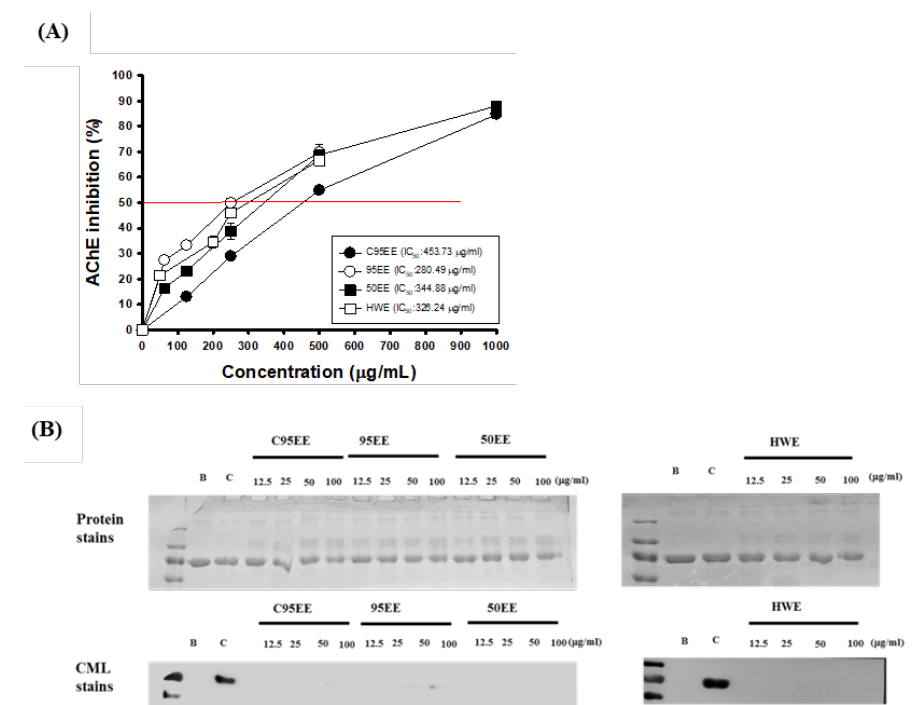
Figure 1. Effects of different TT-hull extracts on ( A ) acetylcholinesterase (AChE) inhibitory activities; ( B ) anti-non-enzymatic glycation in bovine/galactose system by protein staining and immune staining. The TT-hulls were extracted by steeping them in cold 95% ethanol (C95E), refluxing 95E, refluxing 50E, or refluxing hot water (HW) to obtain C95EE, 95EE, 50EE, and HWE, respectively. The quantitative data were presented as mean ± SD of three independent experiments.